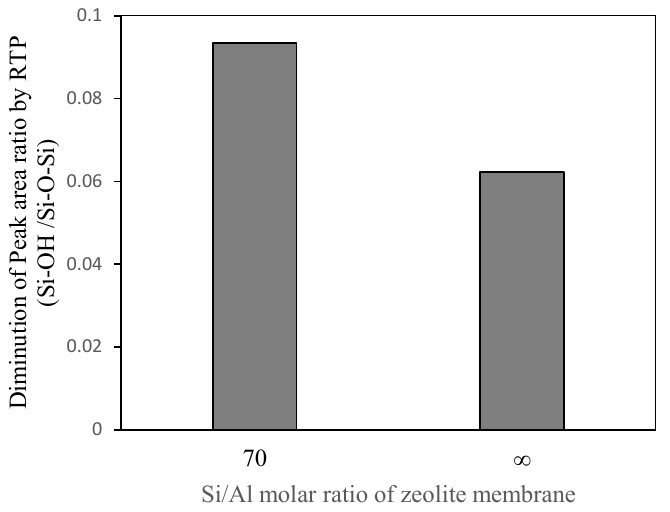
Figure 15. Diminution of the peak area ratio (Si–O–H/Si–O–Si) of ZSM-58 membranes with different Si/Al molar ratios after RTP treatment.